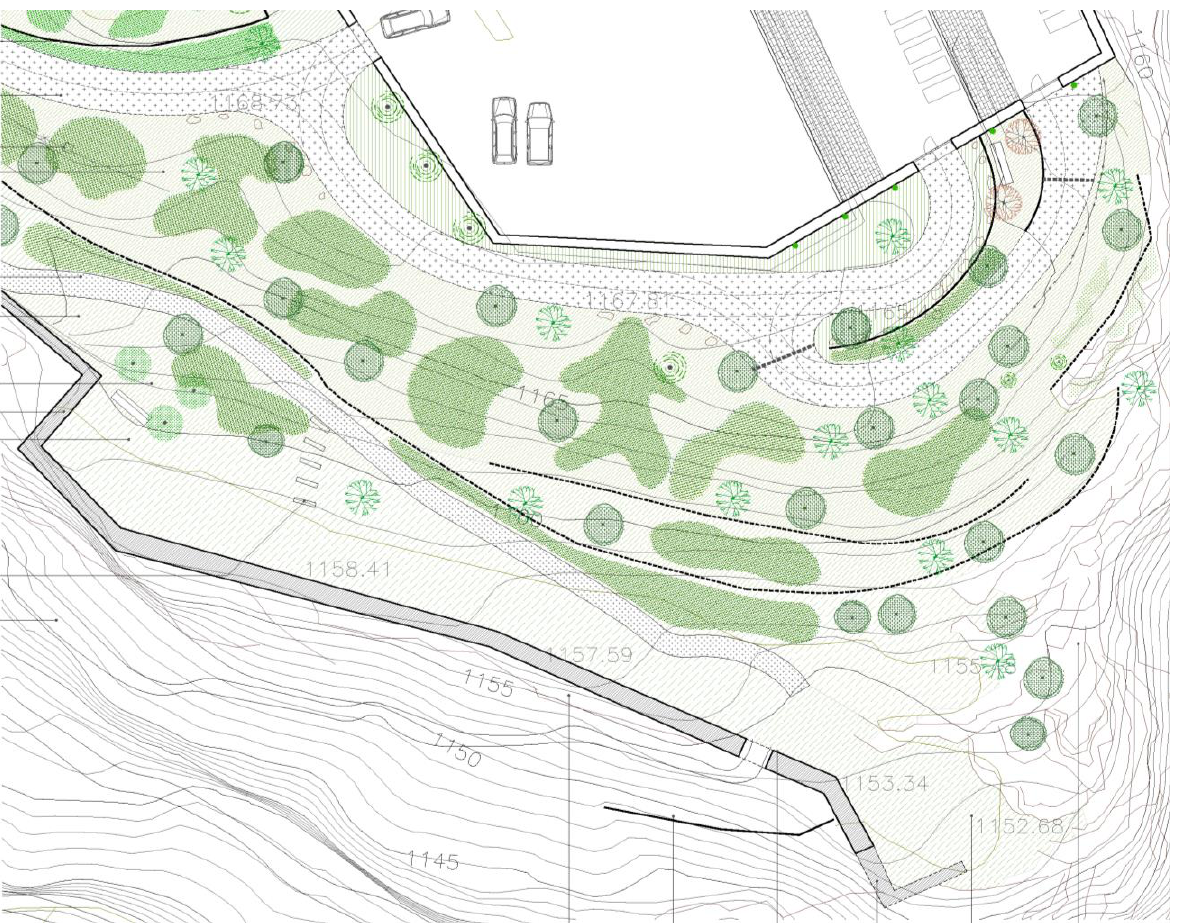
Figure 9. Plan of the projected landscape intervention (Díaz and Baró,